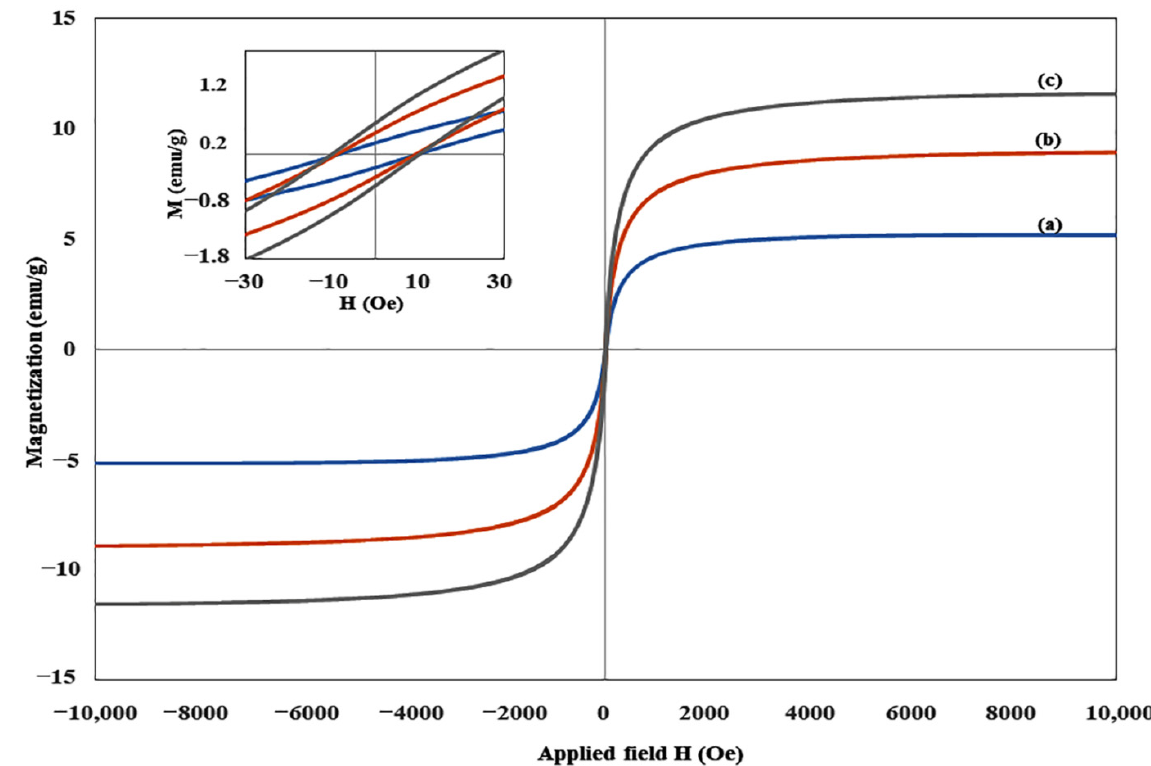
Figure 6. Field-dependent magnetization ( M versus H ) curves of ( a ) PVA/BM20, ( b ) PVA/BM40 and ( c ) PVA/BM60.